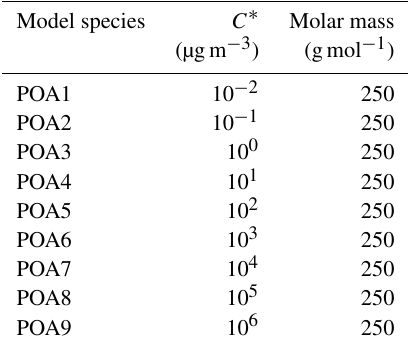
Table 9. List and characteristics of the POA compounds. Model